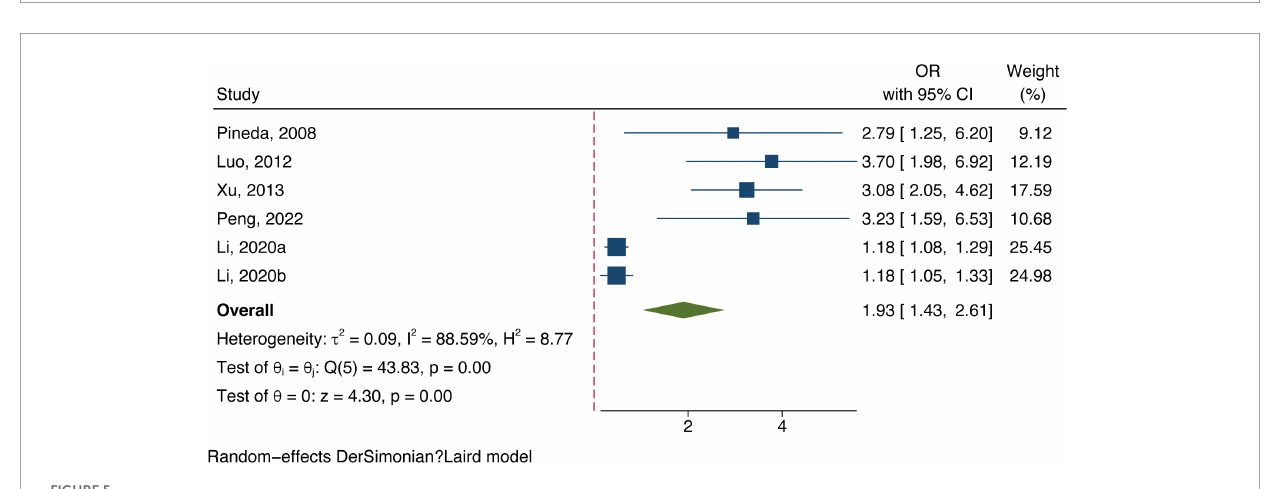
FIGURE5 Forest plot of the association between direct bilirubin level and ischemic stroke